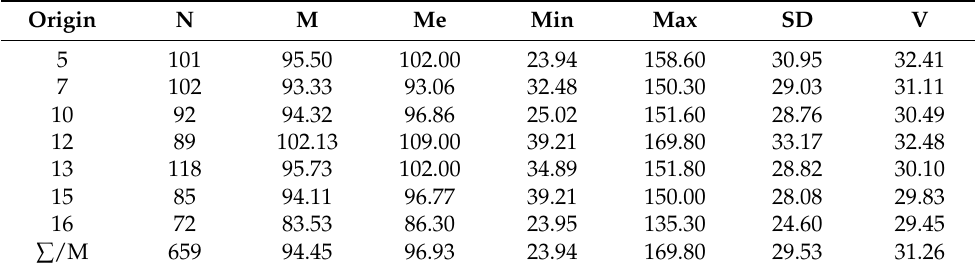
Table 3. Characteristics of static bending strength Rg 12 (MOR) (MPa) of diverse genetic origins (N— Number of groups; M—Average; Me—Median; Min—Minimum; Max—Maximum; SD—Standard deviation; V—Coefficient of variation).